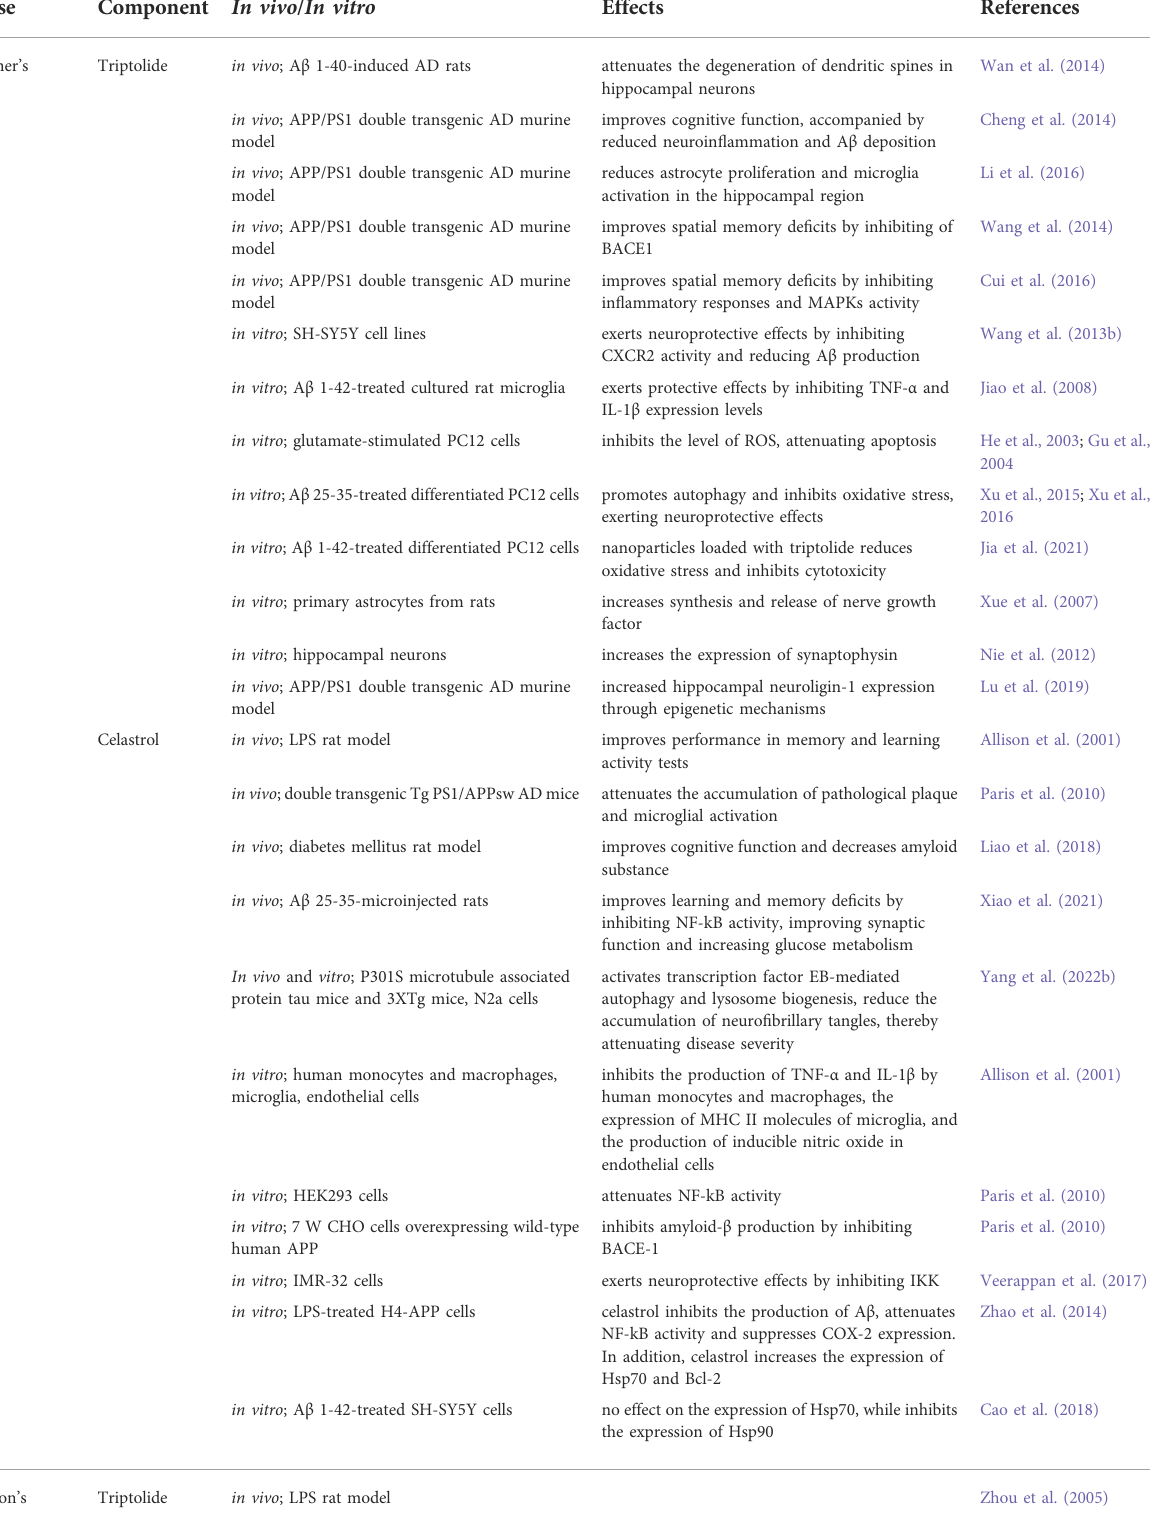
TABLE 1 Effects of triptolide and celastrol on neurological diseases.